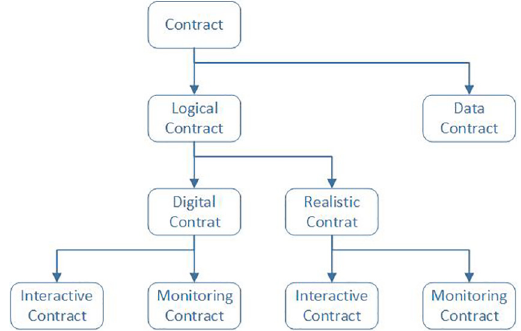
Figure 5. Classi fi cation criteria for atomic